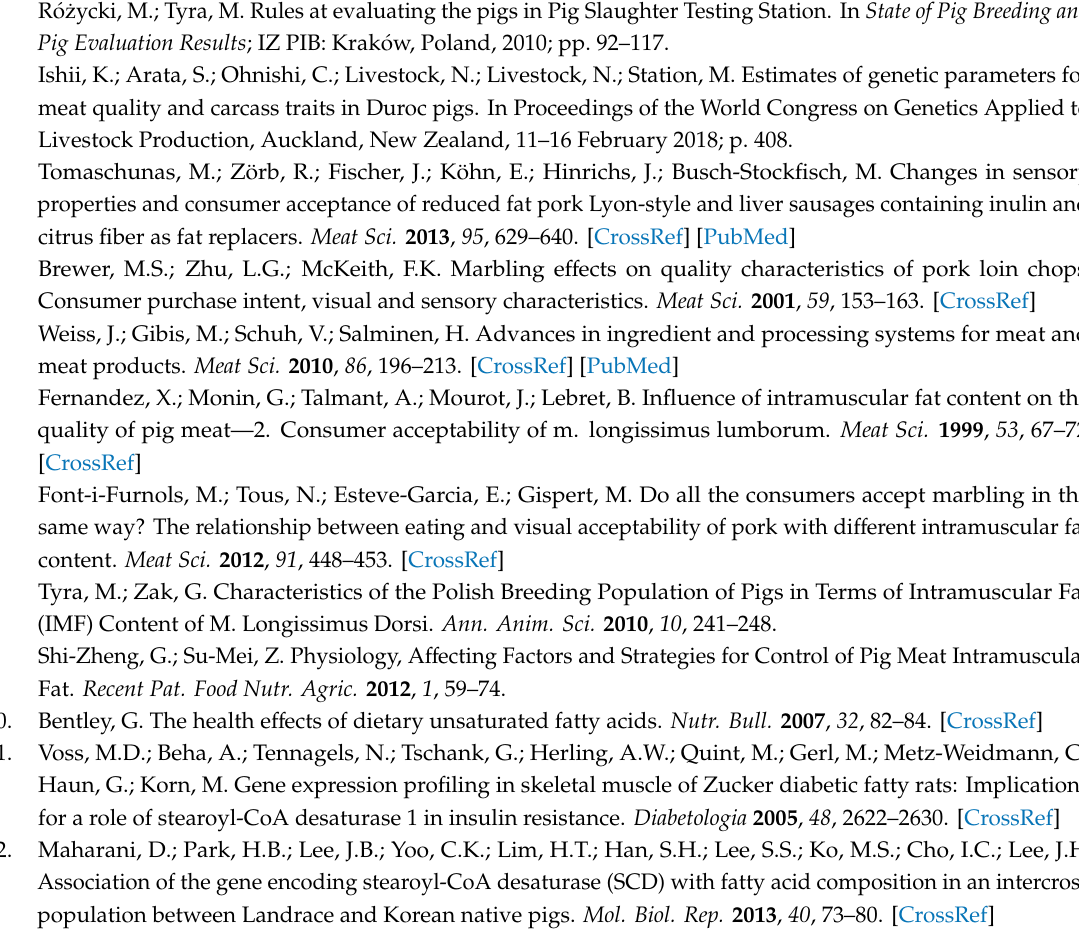
Table S1: Pig trait values dependent on breed e ff ect (mean ± S.D). Table S2: The frequencies of genotypes and alleles in FASN gene. Table S3: The frequencies of genotypes and alleles in SCD gene. Table S4: The frequencies of genotypes and alleles in ACACA gene. Table S5: Association of FASN mutation and analysed traits (LSM ± S.E.). Table S6: Association of the ACACA mutation and analysed traits (LSM ± S.E). Table S7: Association of SCD mutation and analysed traits (LSM ±